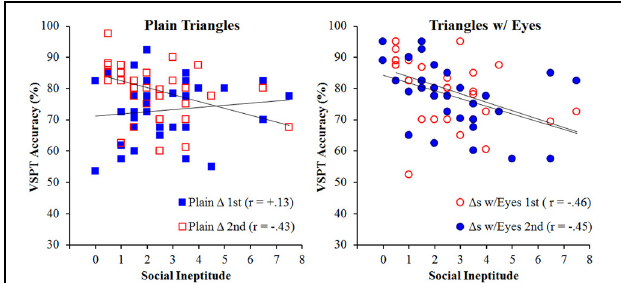
FIGURE 4 | VSPT performance as a function of social ineptitude score separately for the plain triangles (left) and triangles-with-eyes (right) conditions broken out by order for Experiment